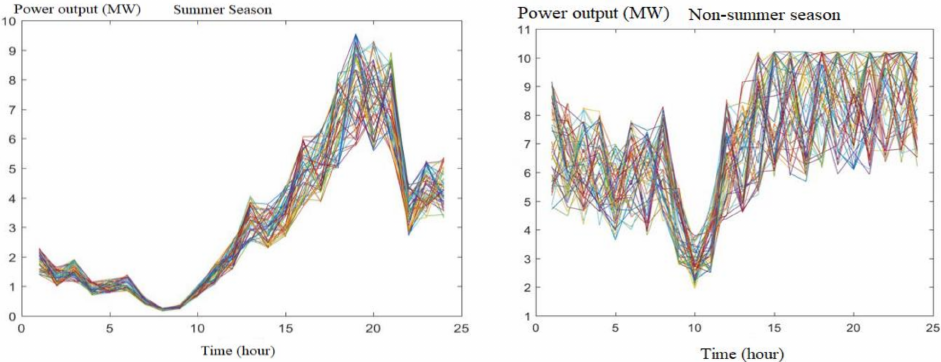
Figure 8. The power output of WT in the summer and non-summer